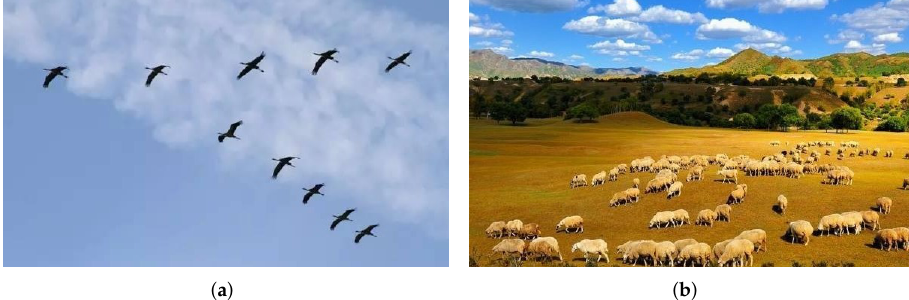
Figure 1. Biological cluster phenomenon in nature. ( a ) Formation migration of wild geese. ( b ) Cluster migration of a